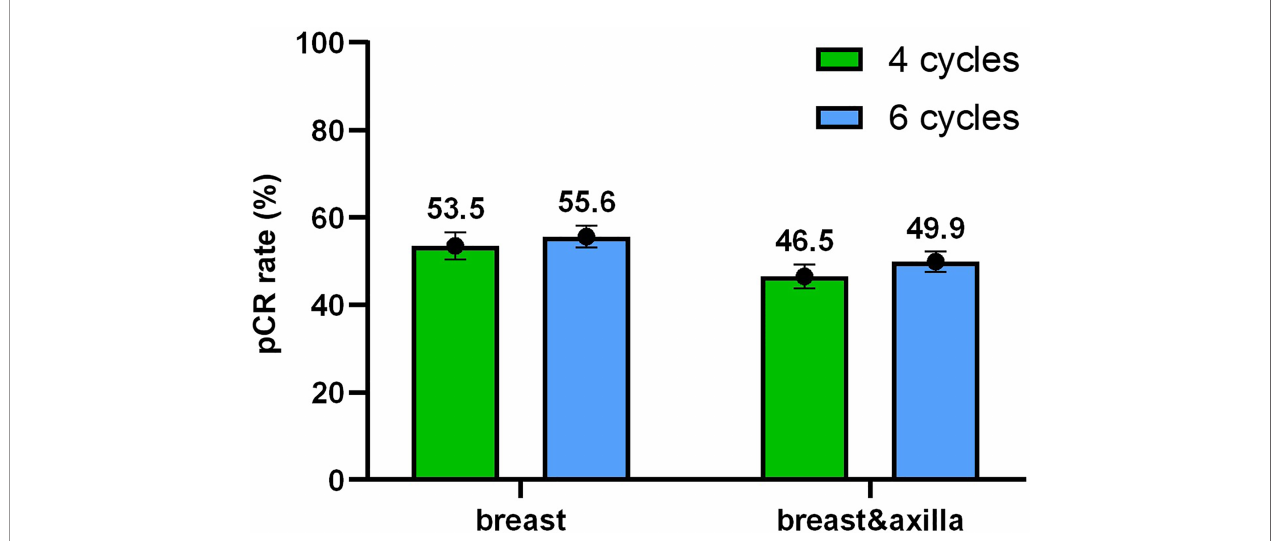
FIGURE 2 | Tumorresponse.Thepathologiccompleteresponse(pCR)ratewith95%con fi denceintervalsinthebreastandinthebreastandaxilladependedondifferentcycles.